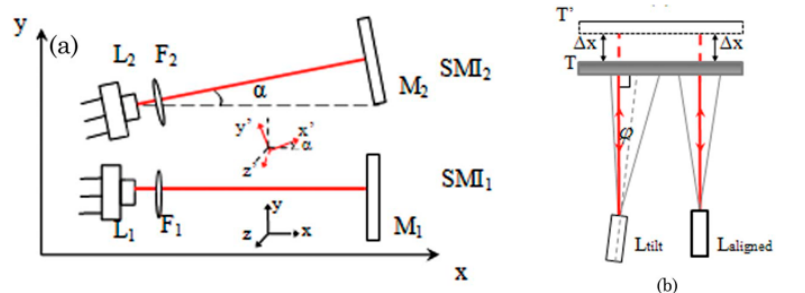
Figure 4. ( a ) In-plane (xy) projection of a 3D arrangement of three OF displacement sensors for simultaneous measurement of three degrees of freedom of target motion. ( b ) Grey lines draw the optic rays of a divergent laser beam, required to compensate the target tilt around the z -axis (adapted from Reference [32]).